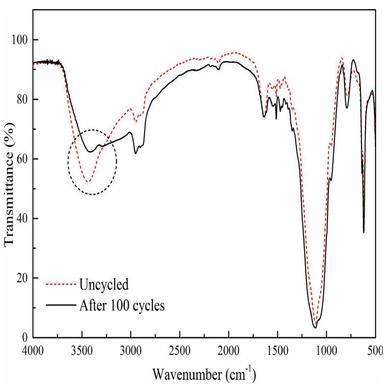
FTIR spectra of MPCM3 before and after 100 thermal cycles.